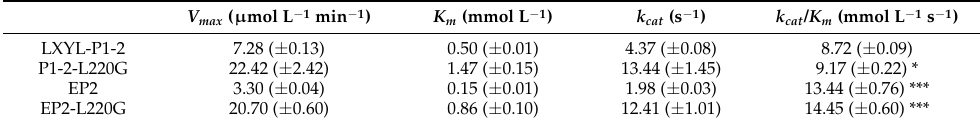
Table 1. Kinetic parameters for the hydrolysis of XDT by mutants harboring L220G mutation.